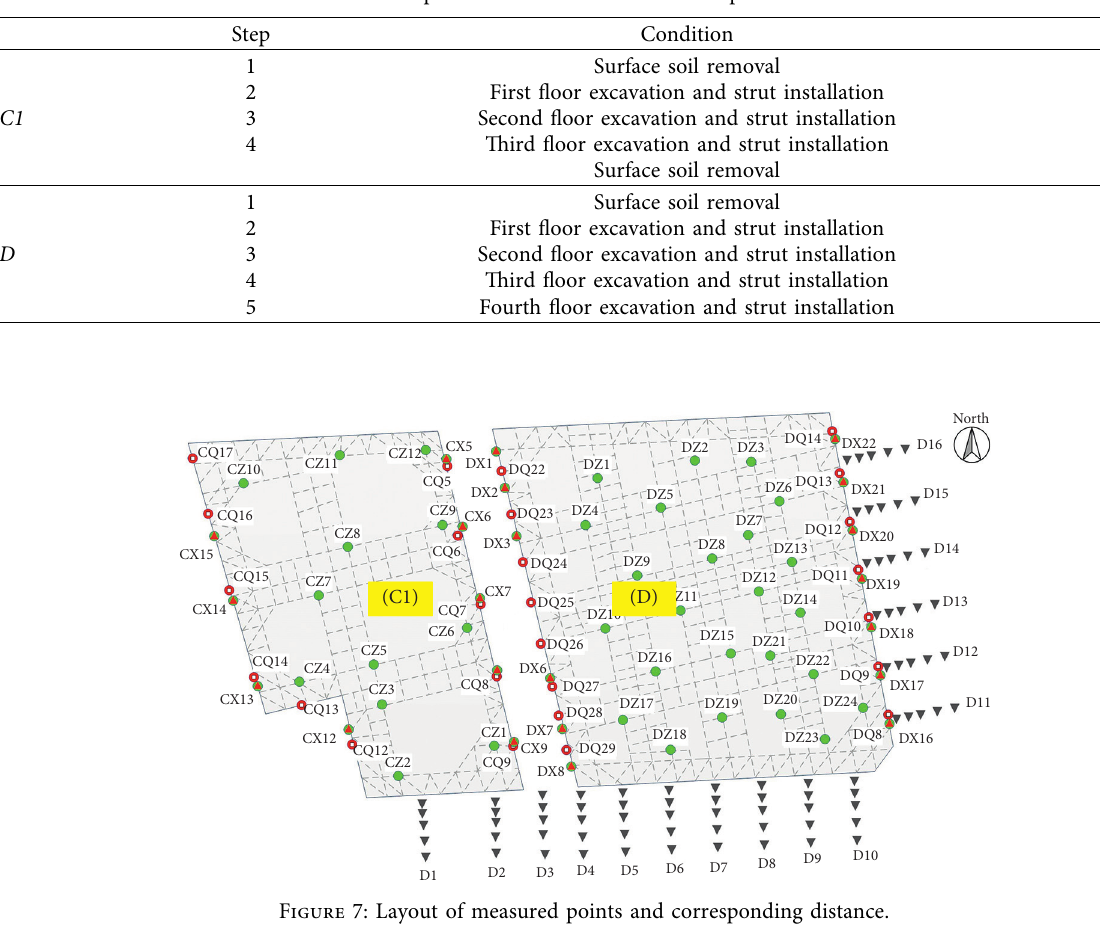
Table 3: Simplified construction schedule for pits C1 and